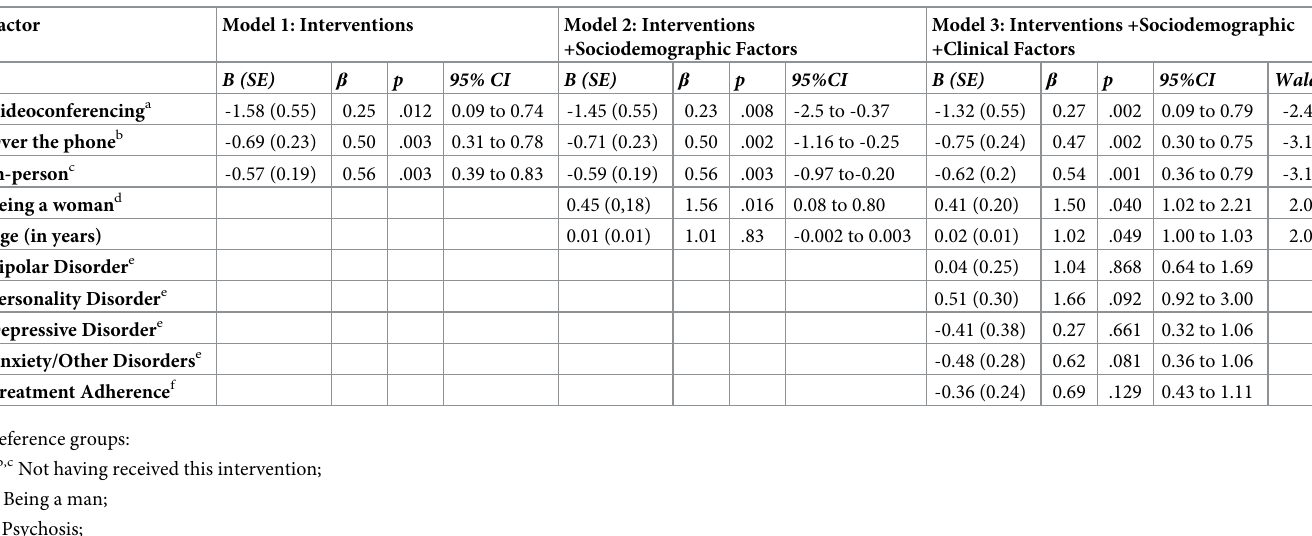
Table 4. Multilevel logistic regression models predicting hospitalizations 6 months after the